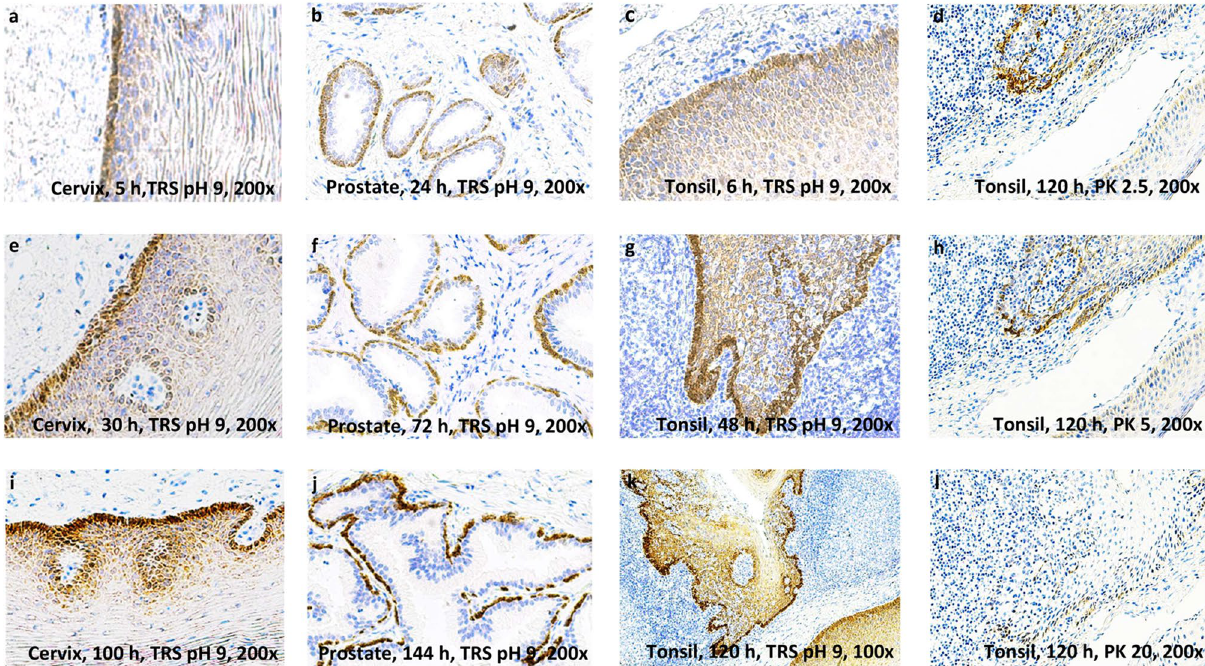
Figure 4. In situ hybridization. The images were taken at ×200 or ×100 ( k ) optic zoom with light microscopy. All tissues display miR-205-5p staining (brown staining). MiR-205-5p expression is restricted to basal epithelial cells. ( a – c , e – g , i – k ) display Heat-induced microRNA Retrieval using Target Retrieval Solution (TRS) pH 9 (20 min at 100 °C) on prostate, tonsil and cervical tissue fixed in formalin for variable lengths of time (hours, h). Proteinase K (PK) digestion on tonsil tissue: ( d ) (2.5 min), ( h ) (5 min) and ( l ) (20 min). ( a , e , i ) display miR- 205-5p staining in cervical tissue fixed in formalin for 5–100 h. ( b , f , j ) display miR-205-5p staining in prostate tissue fixed for 24–144 h. ( c – d , g – h , k , l ) display miR-205-5p staining in tonsil tissue. ( a , b , c ) display tissues fixed for 5–24 h (Short fixation time). ( e , f , g ) shows tissues fixed for 30–72 h (moderate fixation time). ( d , h – l ) shows tissues fixed for 100–144 h (long fixation